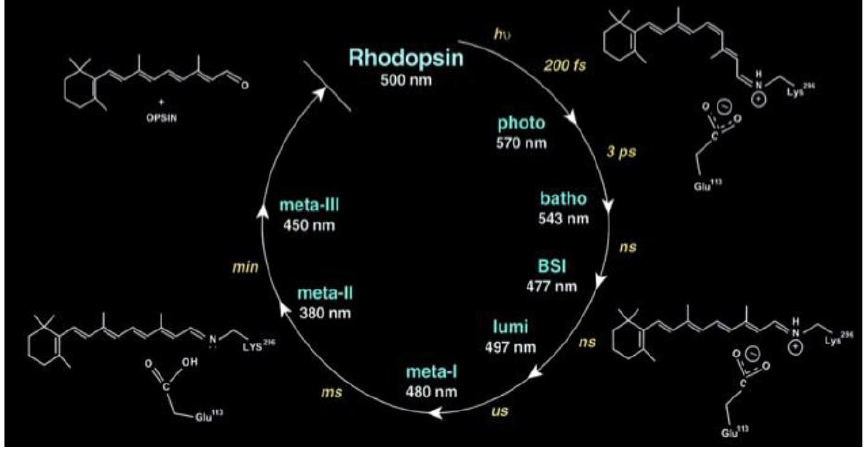
Figure 8. Photoreaction of bovine rhodopsin (reproduced with permission from the American Physiological Society